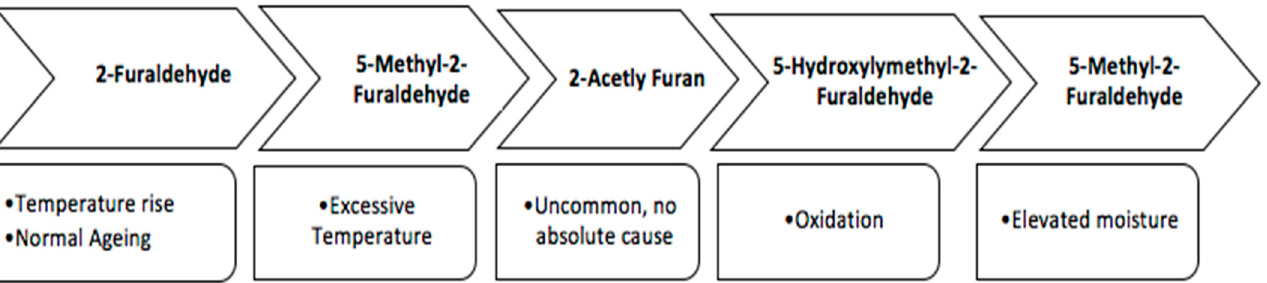
Figure 1. Sources of Furanic compound generation [22].